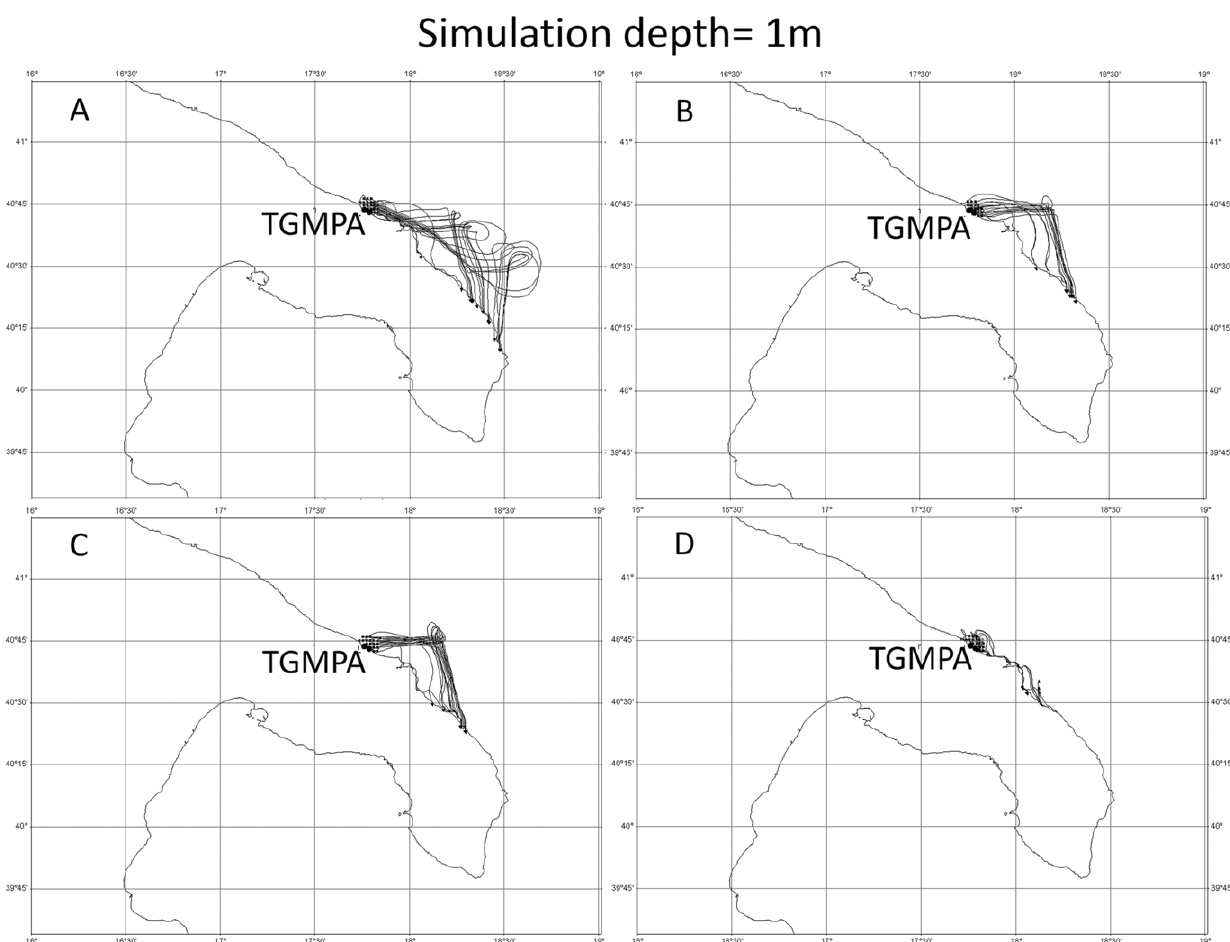
Figure 5. Four Lagrangian simulations at 1 meter depth. Simulations started respectively a) on 9 th , b) 11 th , c) 13 th , d) 15 th of May. All simulations lasted 17 days.